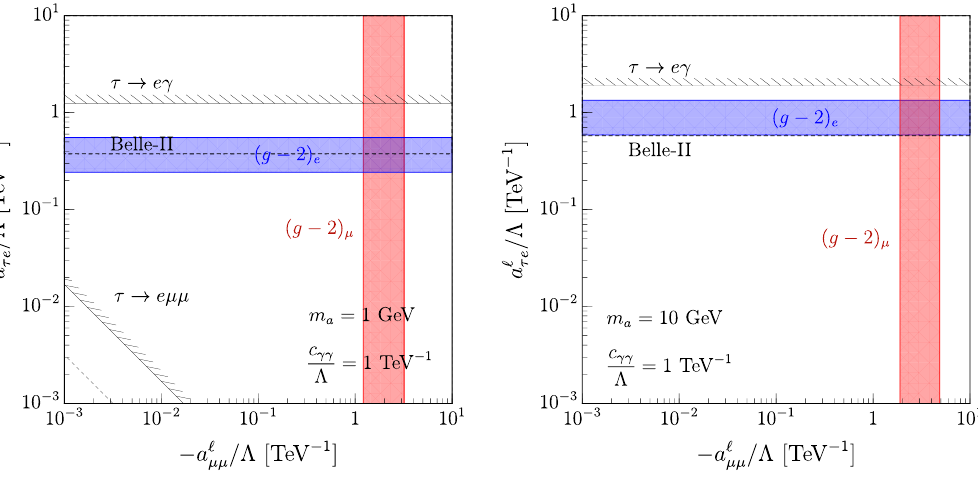
Figure 7 . Allowed regions in the a (cid:22)(cid:22) =a ee vs. c (cid:13)(cid:13) = (cid:3) plane where the ( g (cid:0) anomalies are accounted for at the 90% C.L. . The plots have been obtained setting (cid:3) = 1 TeV, a ee = (cid:3) = 10 TeV (cid:0) 1 (left) and a ee = (cid:3) = 50 TeV (cid:0) 1 (right). In each plot we consider two benchmarks for the ALP mass, namely m a = 1 GeV (solid lines) and m a = 10 GeV (dashed lines).